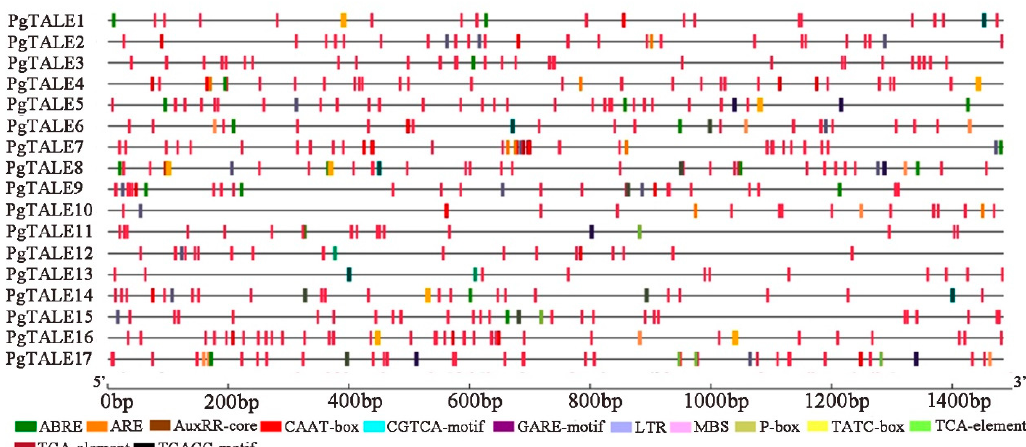
Figure 5. Cis-elements analysis of PgTALE genes. Note: ABRE involved in the abscisic acid responsiveness; ARE involved in anaerobic responsiveness; AuxRR-core and TGA-element involved in auxin responsiveness; CAAT-box involved in promoter and enhancer regions; CGTCA-motif and TGACG-motif involved in the MeJA-responsiveness; GARE-motif, P-box and TATC-box involved in gibberellin-responsiveness; LTR involved in low-temperature responsiveness; MBS involved in drought-inducibility; TCA-element involved in salicylic acid responsiveness.